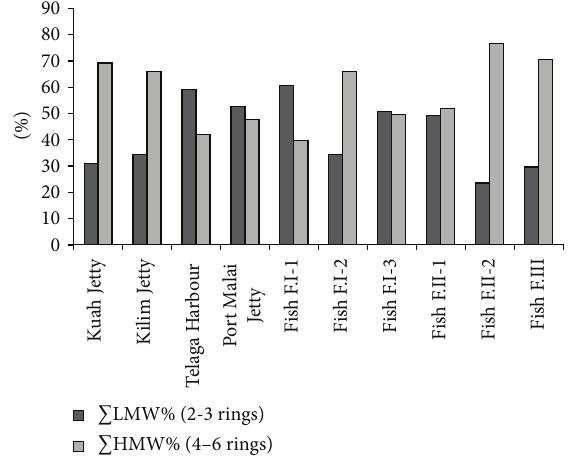
Figure 3: Relative percentages (%) of ∑ LMW and ∑ HMW in the sediment of different sampling